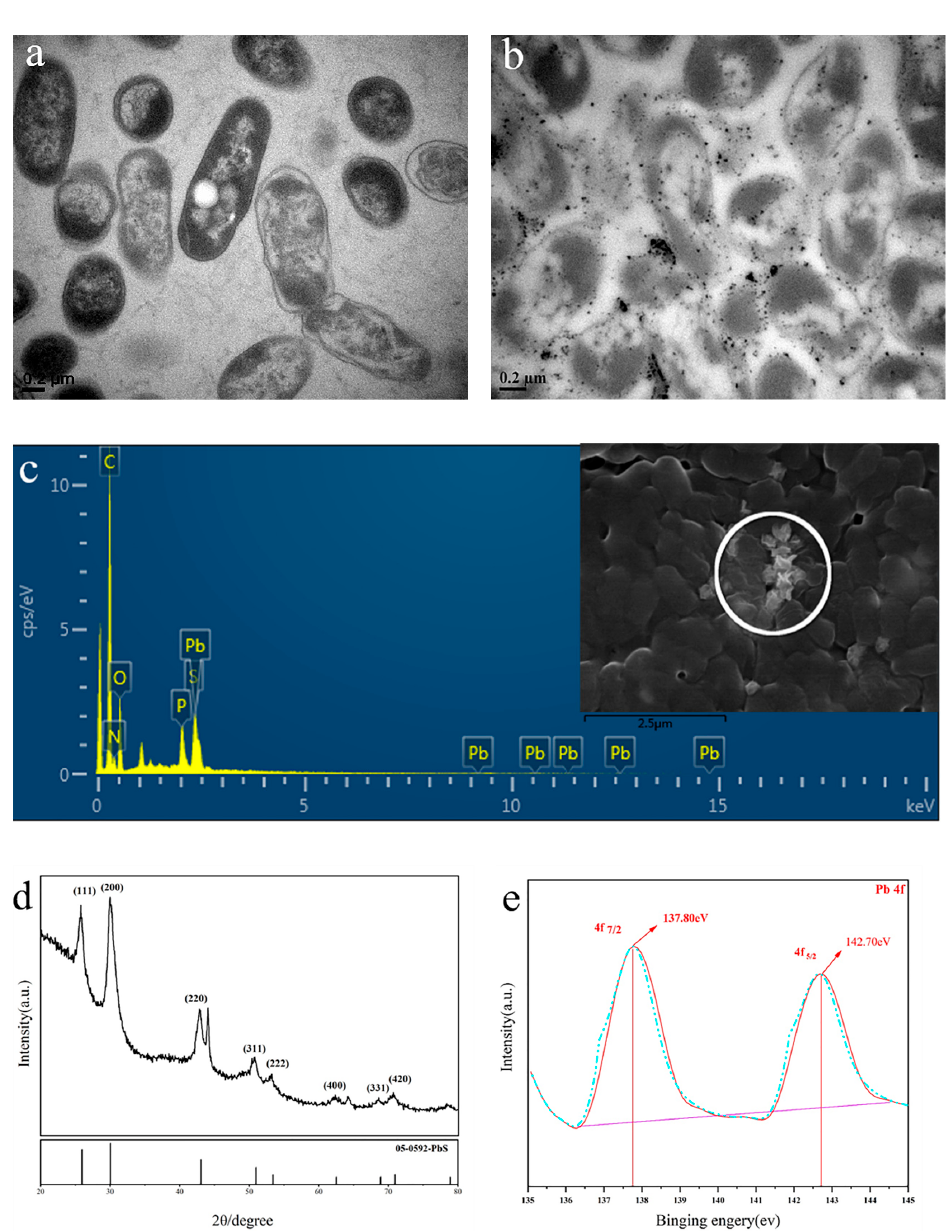
Figure 2. The characterization of the black materials synthesized by Shinella zoogloeoides PQ7. ( a ) Transmission electron microscope (TEM) image of control cells; ( b ) TEM image of cells with nanoparticles; ( c ) Scanning electron Microscopy–energy dispersive X-ray spectroscopy (SEM–EDS) of PQ7 grown with Pb (5 mM); ( d ) X-ray diffraction (XRD) pattern of PbS nanoparticles synthesized by PQ7; ( e ) X-ray photoelectron spectroscopy (XPS) image of PbS synthesized by PQ7.